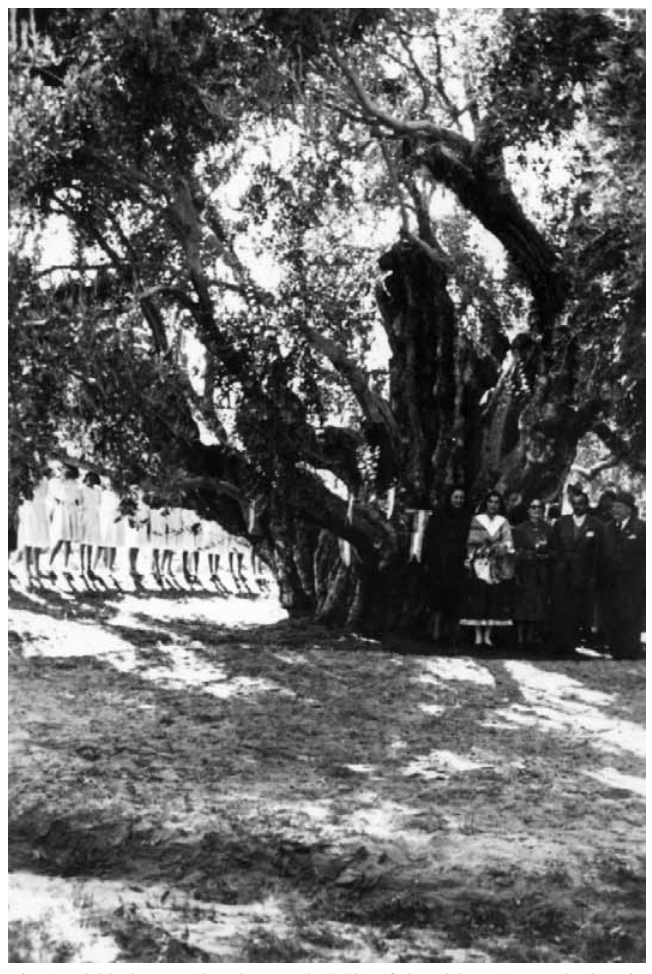
Fig. 1 - Old picture (dated around 1950) of the oldest ‘Arauco’ plant in Argentina.